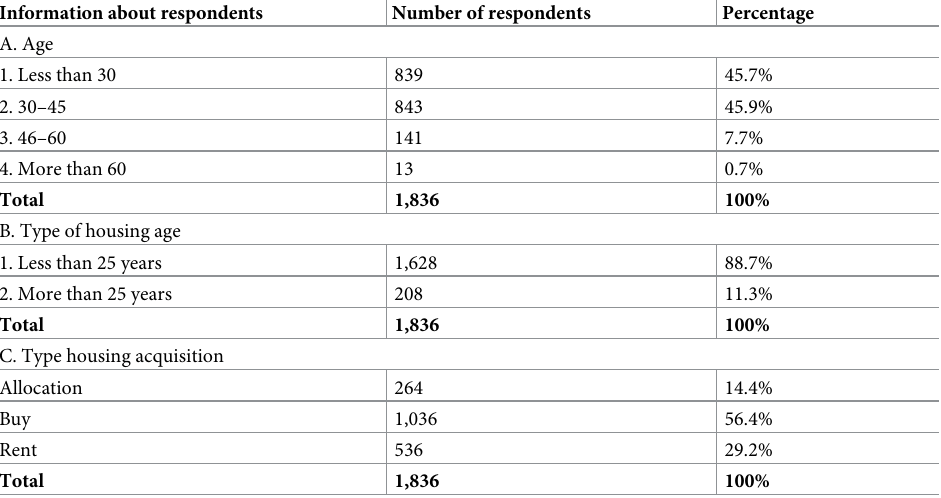
Table 2. Background profiles of the survey